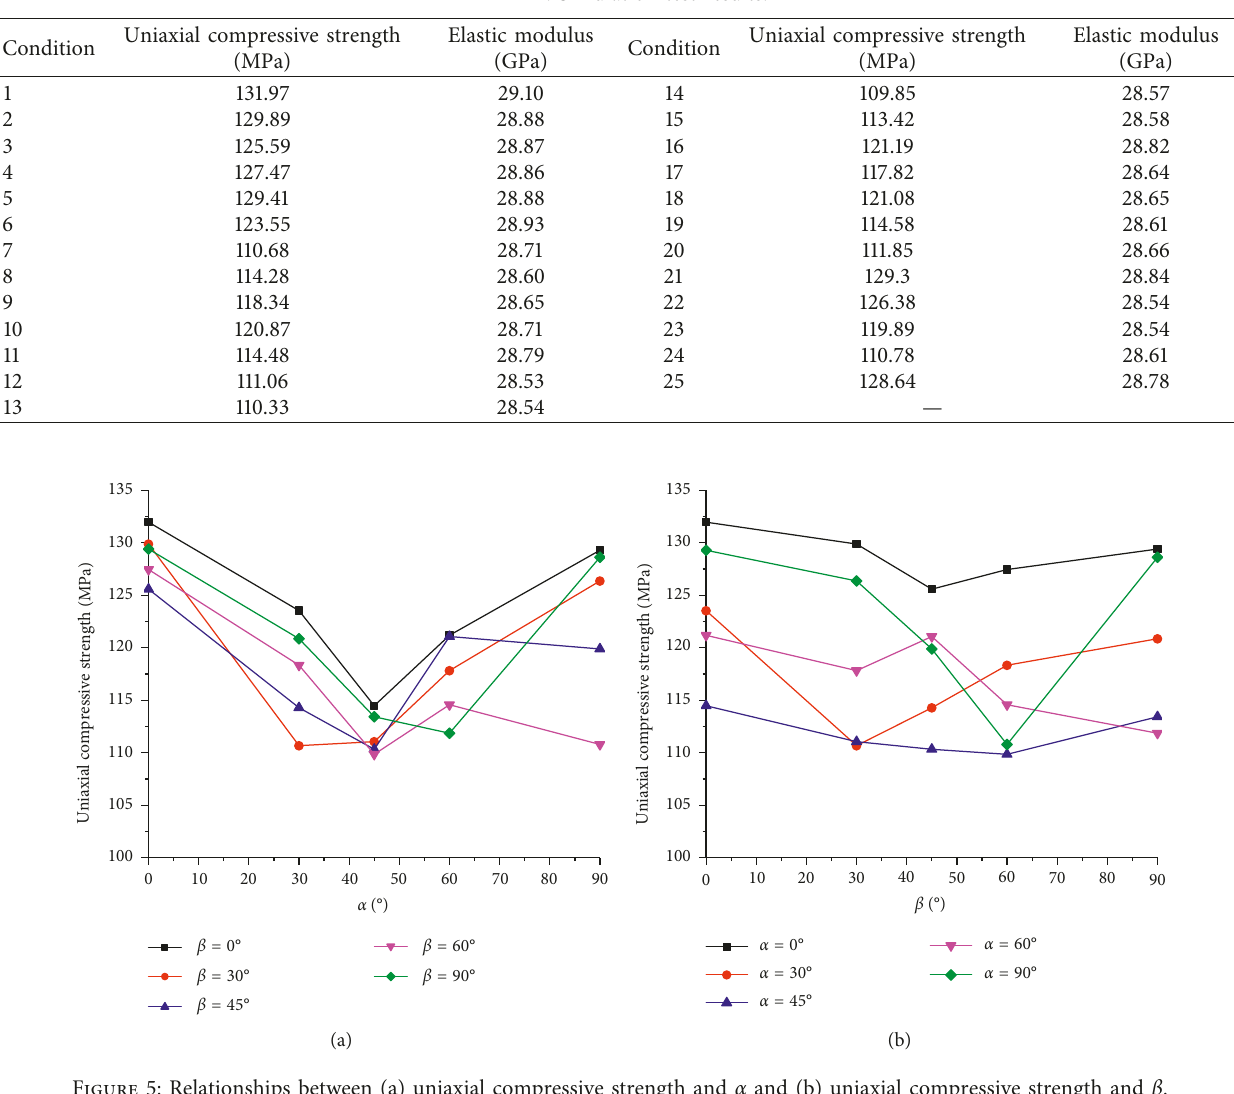
Figure 5: Relationships between (a) uniaxial compressive strength and α and (b) uniaxial compressive strength and β